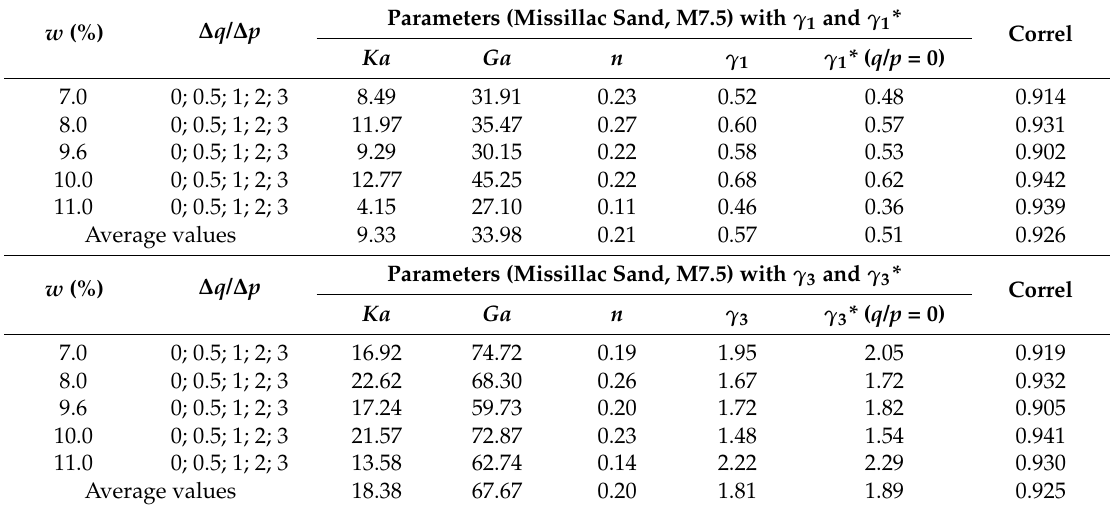
Table 5. Parameter optimization of the modified Boyce model for M7.5.